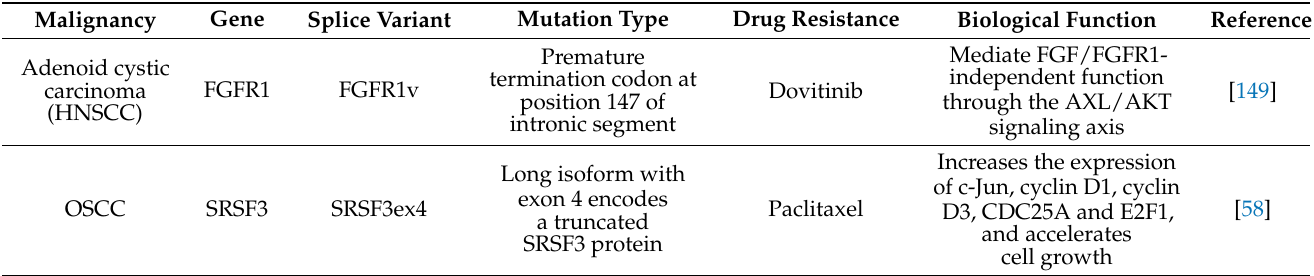
Table 4. AS and effects on drug resistance in head and neck squamous cell